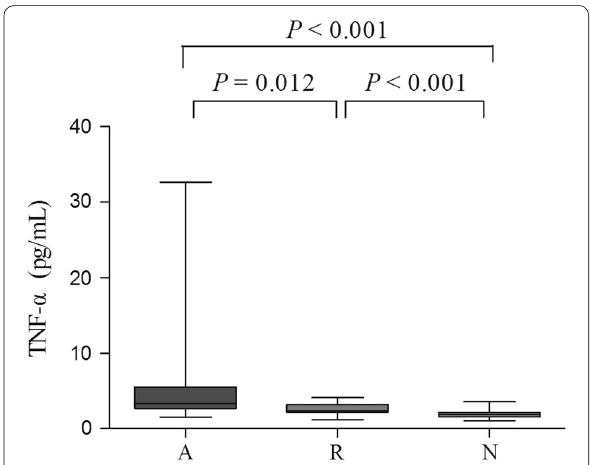
Fig. 2 Serum levels of TNF‑α from SJS/TEN patients during the acute phase (lane A), SJS/TEN patients during the resolution stage (lane R), and normal subjects (lane N). Statistical significance was determined by Wilcoxon‑Mann–Whitney for comparisons between lane A and lane R, and between lane A and lane N. Student’s t test was used when comparing lane R with lane N. Box 25th and 75th percentiles; = bars min and max values; line inside box = =